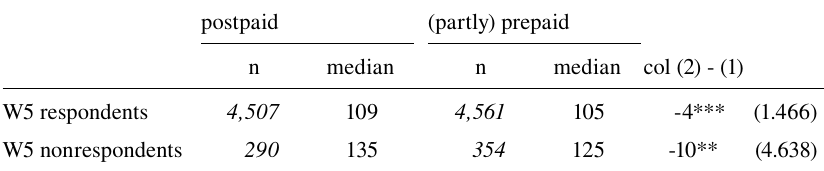
All 4,797 14,560